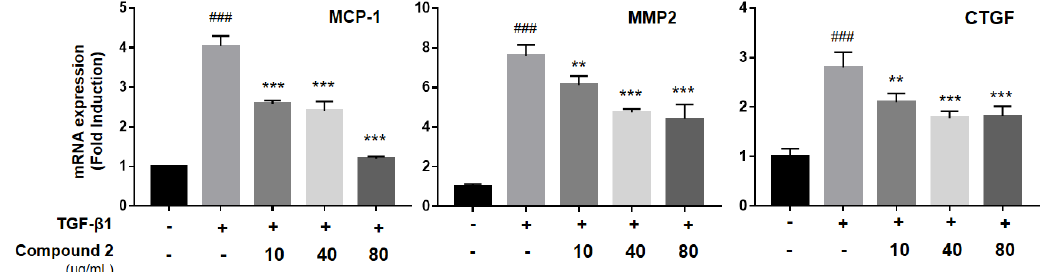
Figure 5. Compound 2 inhibited TGF-β1-induced myofibroblast associated genes in alveolar epithelial A549 cells. A549 cells were treated with TGF-β1 (2 ng/mL) and compound 2 for 48 h. Any expression of MCP-1, MMP2 and CTGF was analyzed by qPCR-analysis. All of the assays were performed in triplicate, and the data are shown as the mean values ± S.D. Values that are significantly different from the control are indicated by ### p < 0.001, and values that are significantly different from the TGF-β1-treated group are indicated by ** p < 0.01, and *** p < 0.001.